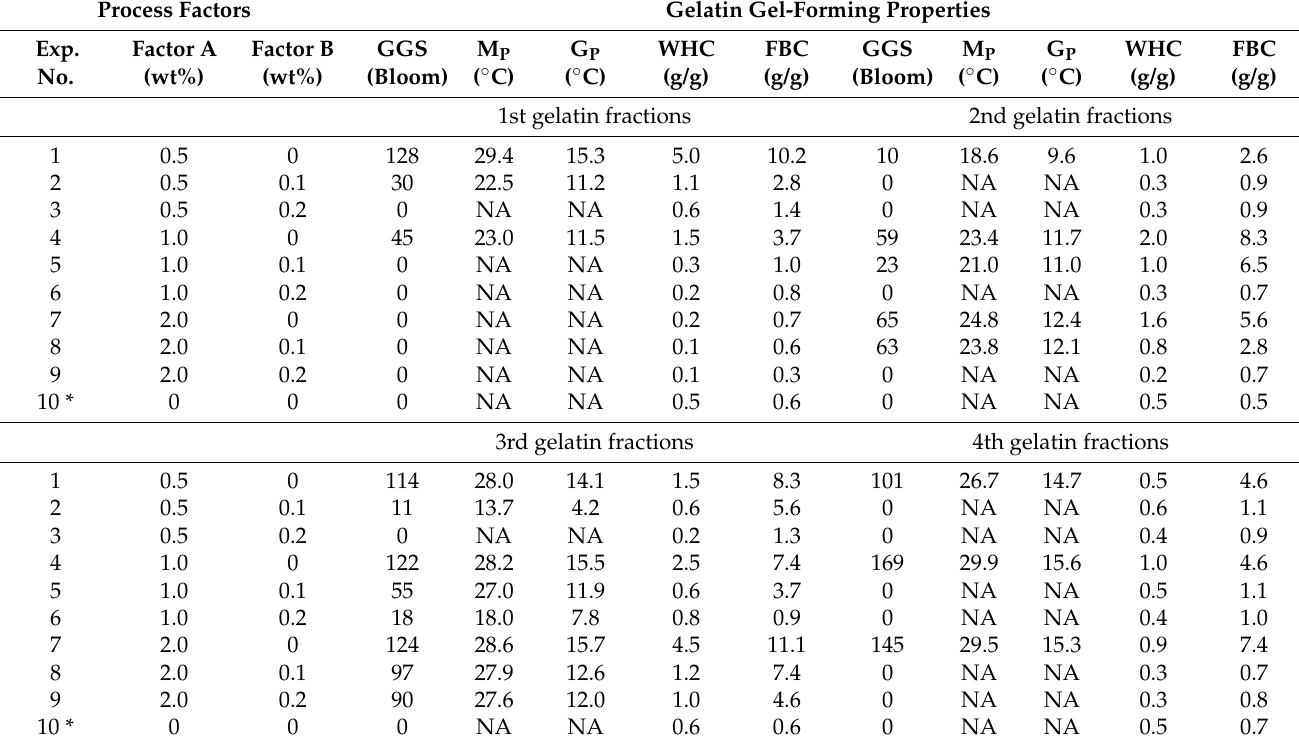
Table 3. Results of analyses of the gel-forming properties of prepared gelatins. Process Factors Gelatin Gel-Forming